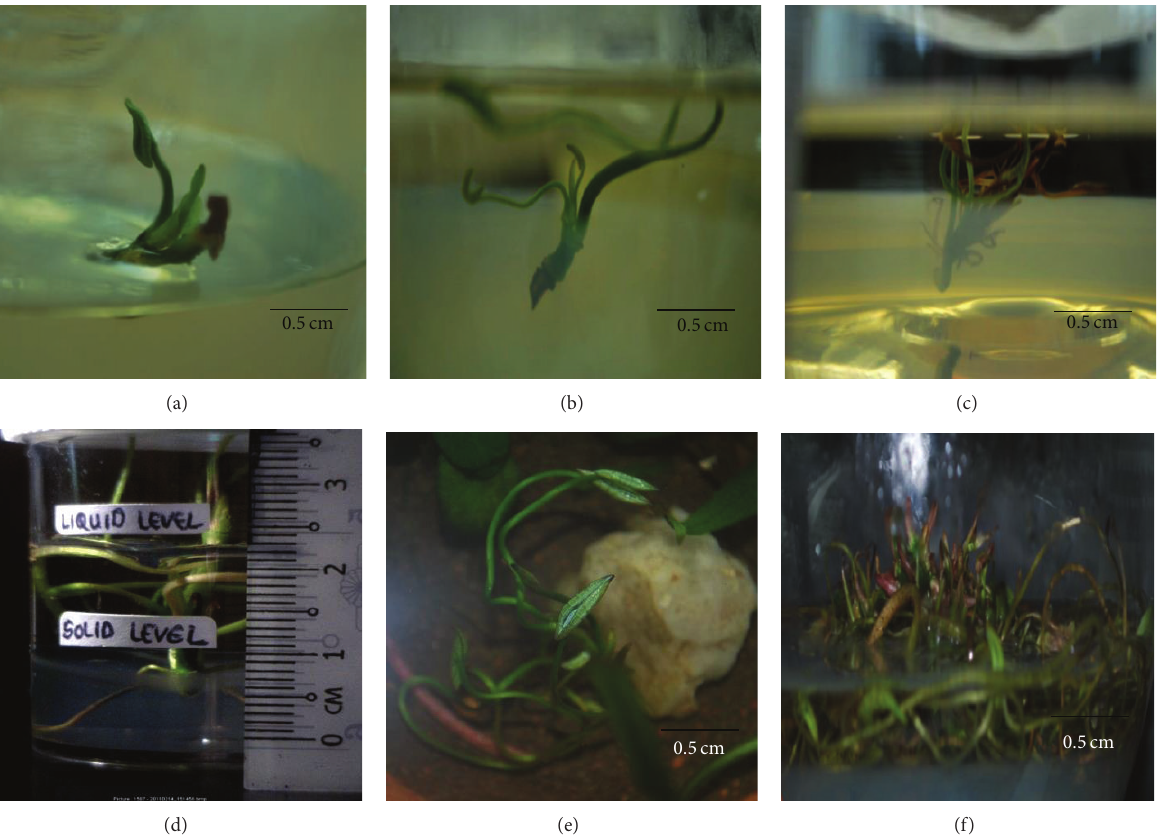
Figure 3: Effects of yellow plumule of N. nucifera on double-layered media (on solid MS media and liquid MS media supplemented with 0.5 mg/L BAP and 1.5 mg/L NAA). (a) Formation of the first and second shoots. (b) Elongation of the first three shoots. (c) Layered multiple shoots after 6 weeks. (d) Formation of roots after 4 weeks of subculture. (e) Elongation of leaves after 7 weeks. (f) Layered multiple shoots after 10